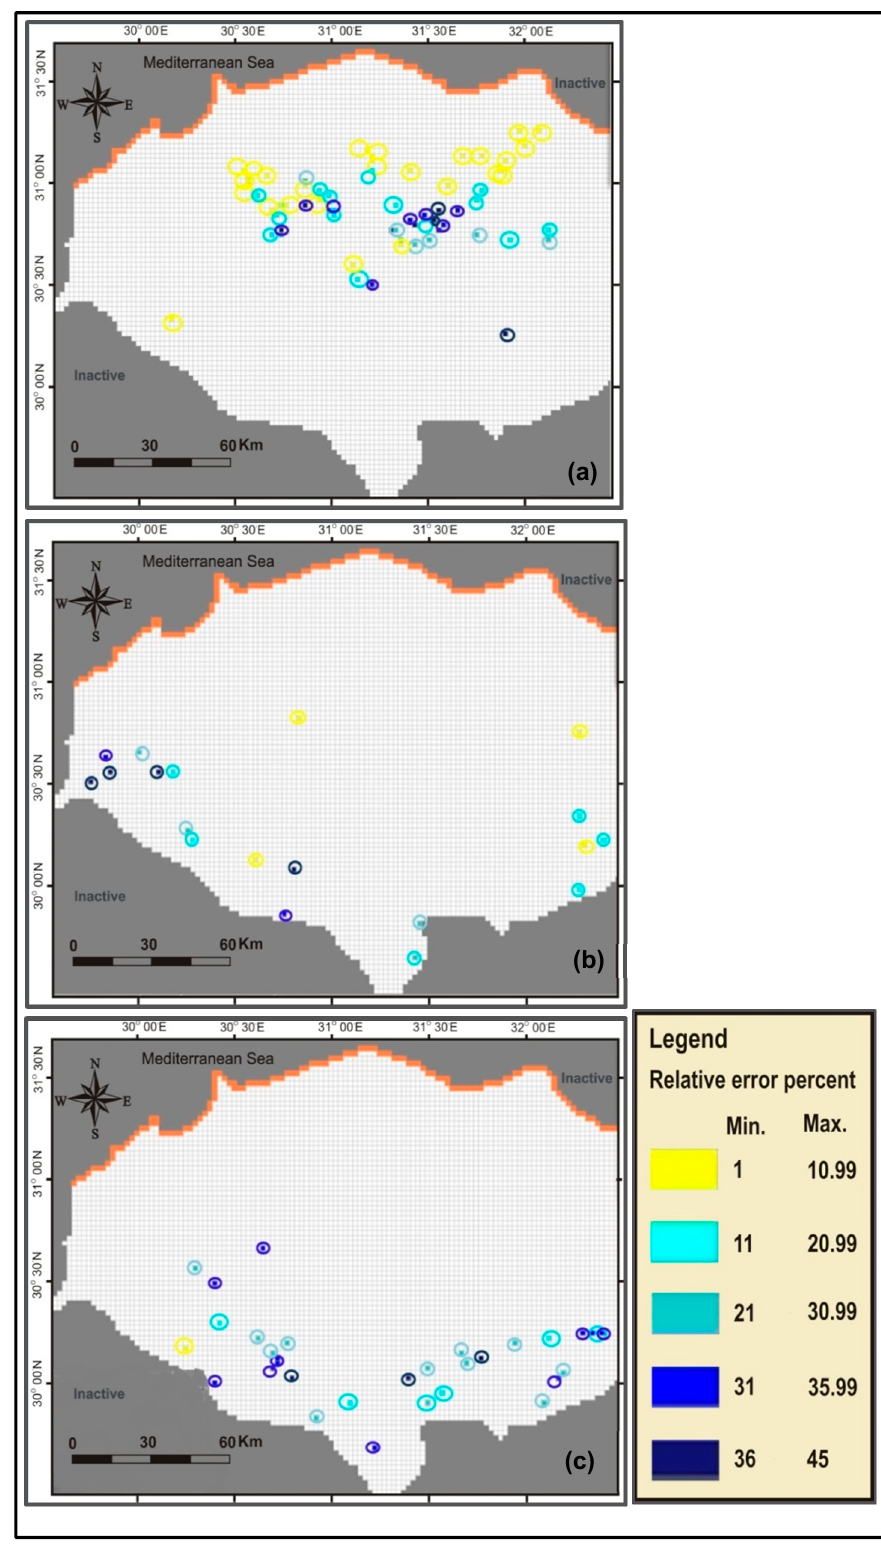
Figure 10. The relative error percent with respect to the modeled salinity concentration value. ( a ) Layers 3, 4, 5, 6, 7; ( b ) Layers 8, 9, 10; ( c ) Layers 11, 12, 13, 14, 15, 16.